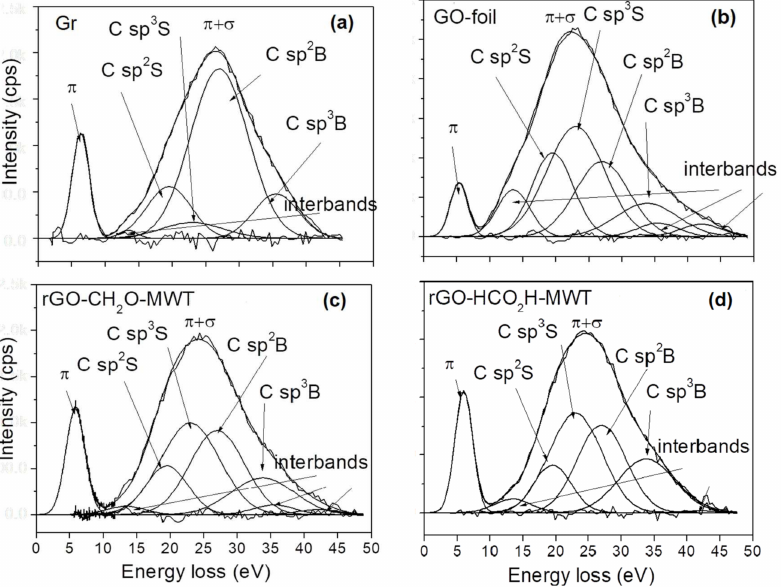
Figure 5. Exemplary REELS spectra fitted using Gaussian functions. Standard deviations are multiplied by 10. ( a ) Gr, ( b ) GO-foil, ( c ) rGO-CH 2 O-MWT, ( d ) rGO-HCO 2